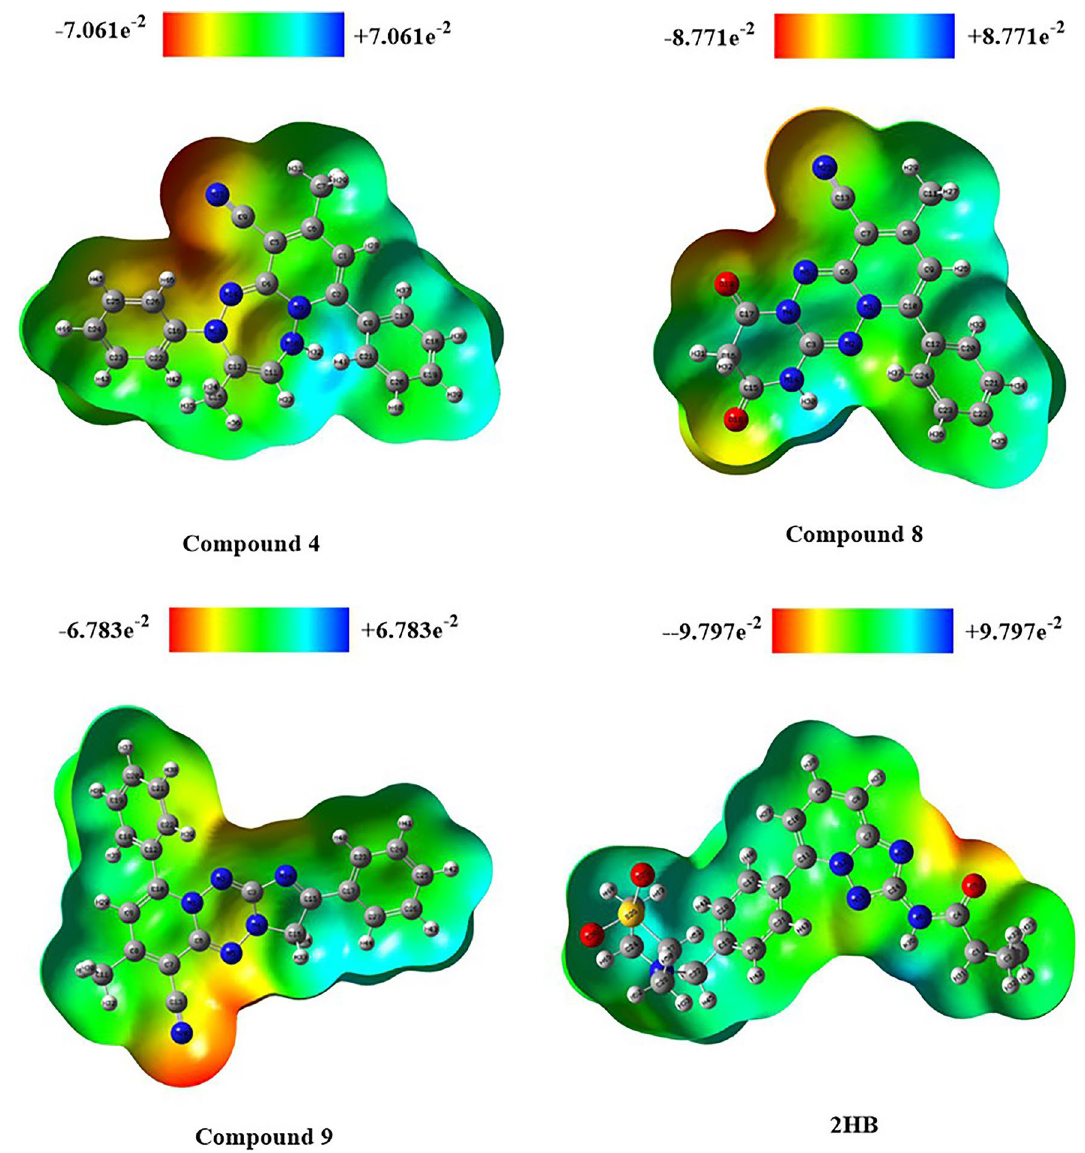
Figure 12. MEP map of compounds ( 4 , 8 , 9 ) and 2HB .